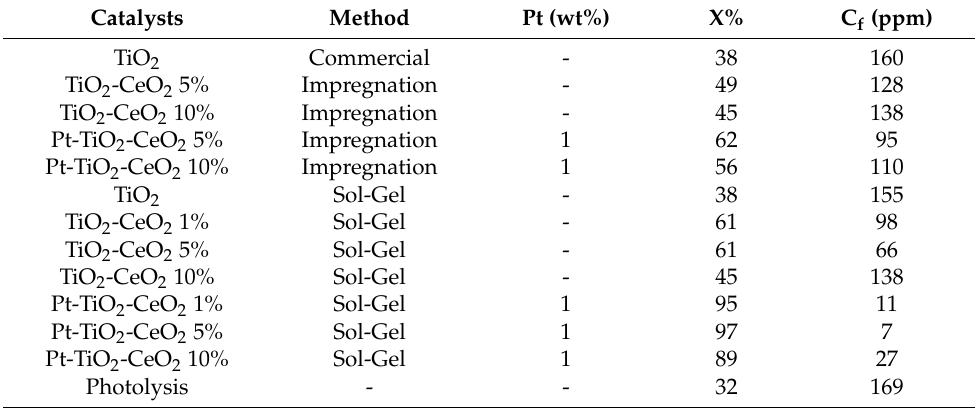
Figure 7. Photocatalysts degradation of 2,4-Dichlorophenoxyacetic acid. ( a ) Impregnation and ( b ) Sol-Gel materials. Table 4. Photocatalysts degradation of 2,4 Dichlorophenoxiacetyc